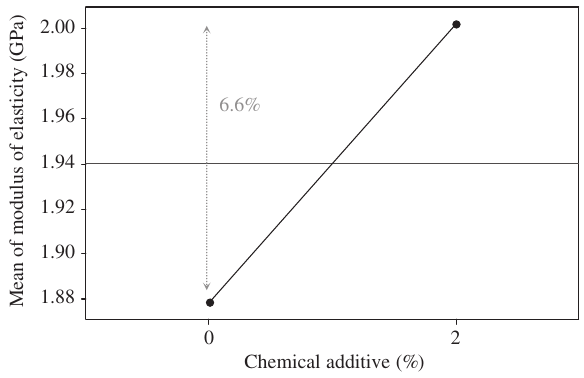
Figure 5 Main effect plot of ‘chemical additive’ for modulus of elasticity response.